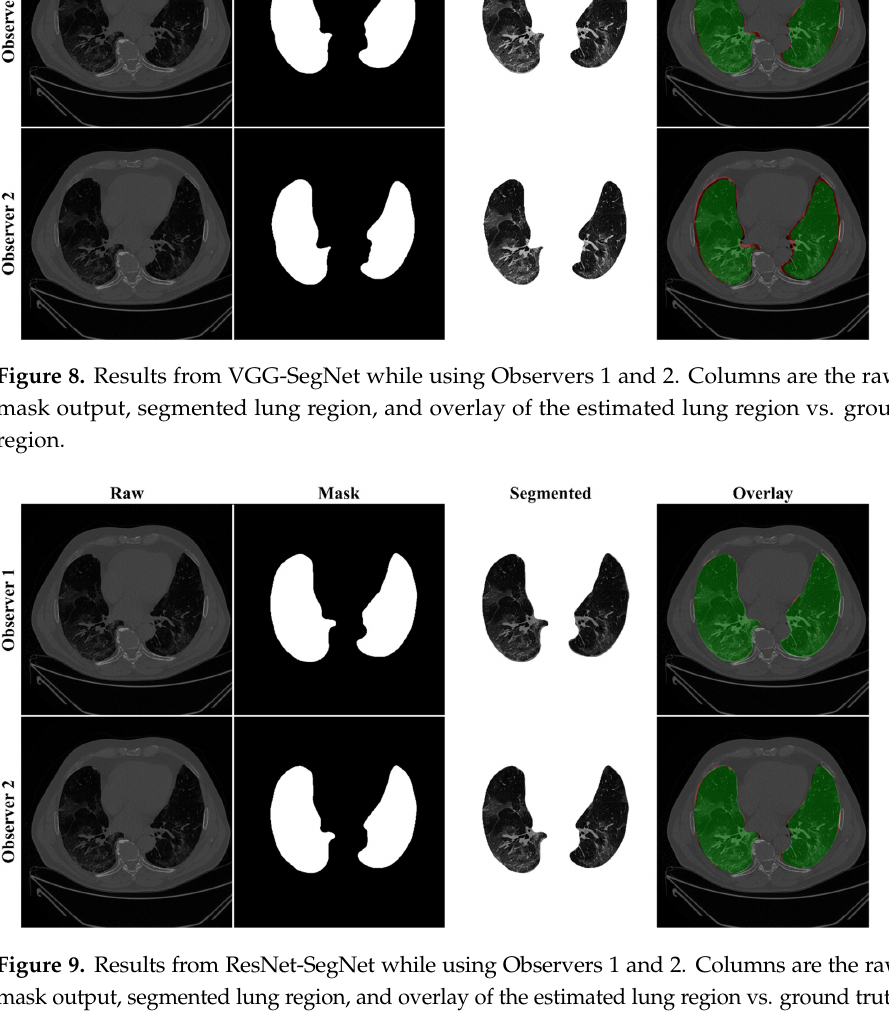
Figure 9. Results from ResNet-SegNet while using Observers 1 and 2. Columns are the raw, binary mask output, seg- mented lung region, and overlay of the estimated lung region vs. ground truth region. mask output, segmented lung region, and overlay of the estimated lung region vs. ground truth